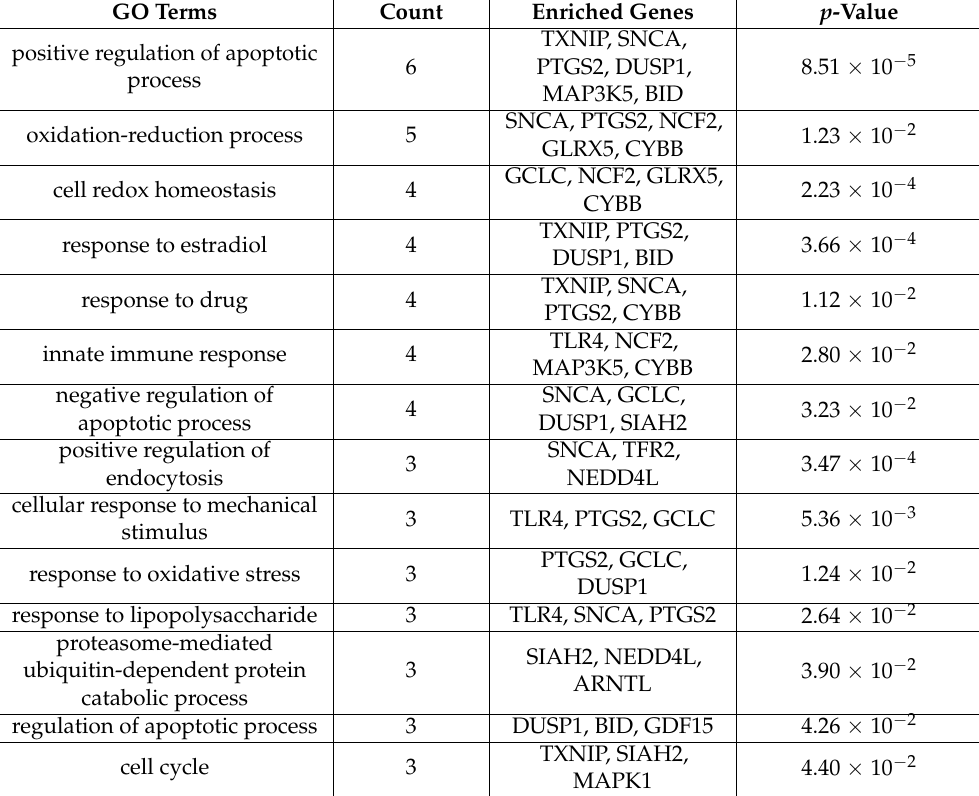
Table 1. GO functional enrichment analysis of 27 ferroptosis-related differentially expressed genes in GIONFH and non-GIONFH samples.